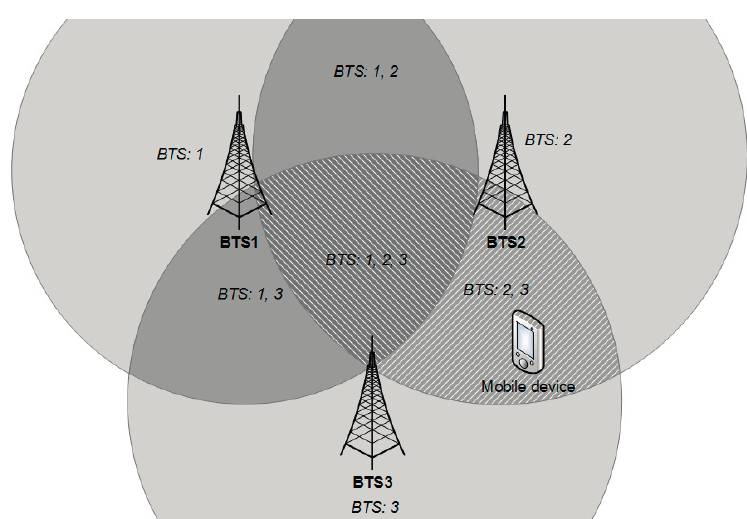
Figure 7. Phase 2 of map reduction